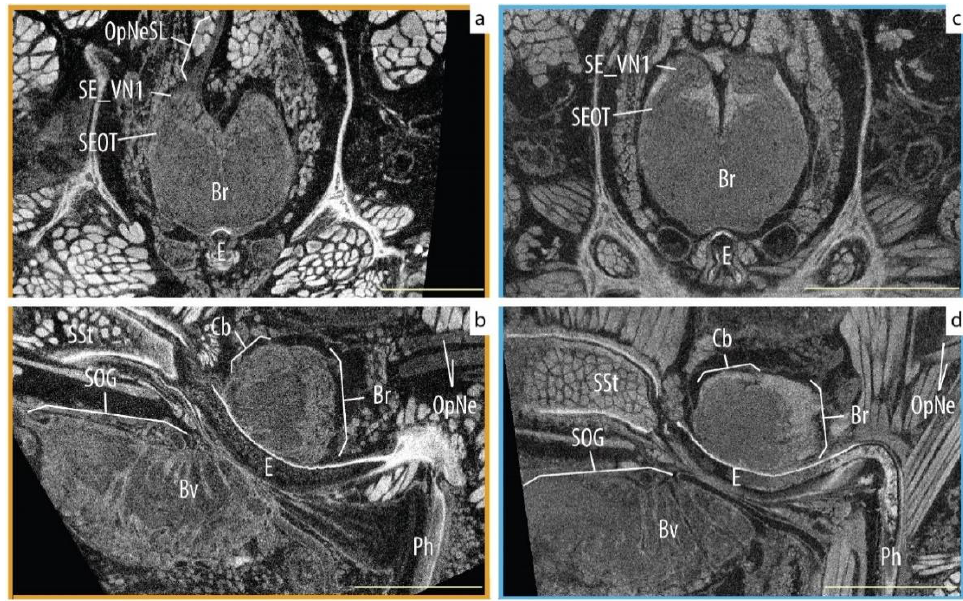
Figure 3. Comparison of Araneus diadematus neuroanatomy. New material was collected in October 2020; the Old specimen was captured in April 1940. ( a , c ) Axial slice of the brain focusing on the secondary eye pathway. ( b , d ) Sagittal slice of the whole CNS. Abbreviations: Br, brain; Bv, blood vessels; CB, central body (arcuate body); E, esophagus; OpNe, optic nerves; OpNeSL, optic nerves of the left secondary eyes; Ph, pharinx; SE_VN1, visual neuropiles 1 (lamina) of the secondary eye pathway; SEOT, secondary optic track; SOG, sub-esophagic ganglion; SSt, sucking stomach. Fresh material ( New ) is marked in dark yellow and legacy material ( Old ) in blue. Scale bars = 0.5 mm.